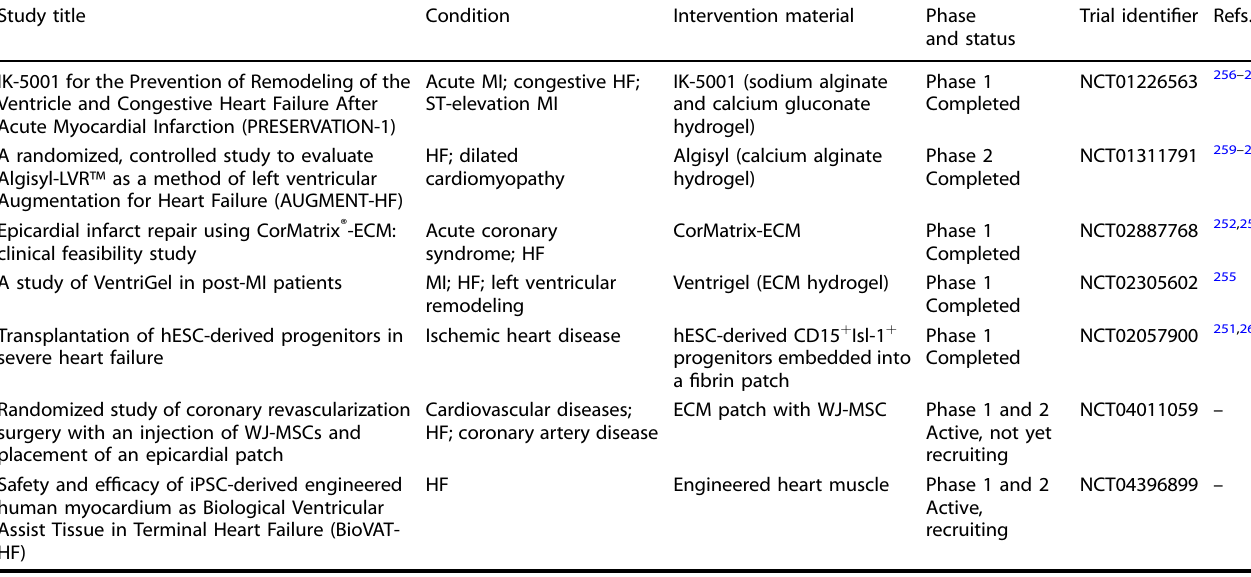
Table 3. Human clinical trial for cardiac tissue engineering (Trial Identi fi er: